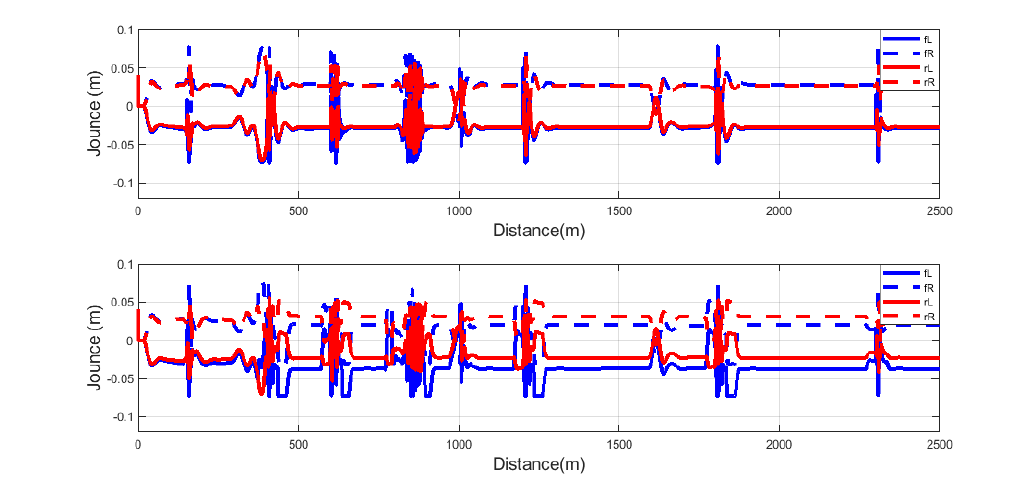
Figure 14. Suspension deflection: non-adaptive ( top ) and adaptive ( bottom ).